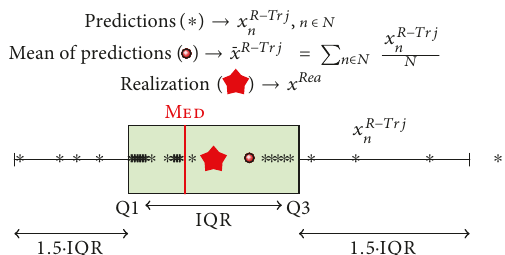
Figure 6: Schematic boxplot including the N robust prediction and the realization of a hypothetical